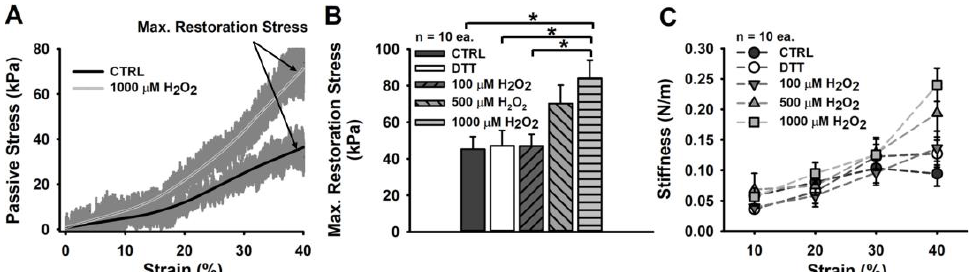
Figure 3. Passive restoration stress increases for larger H 2 O 2 concentrations. ( A ), average stress – strain curve for all CTRL fibres and all fibres exposed to 1000 µM H 2 O 2 . Maximum restoration stress is obtained at 40% strain. ( B ), while DTT and exposure to 100 µM H 2 O 2 had no marked effect on maximum restoration stress, high levels of H 2 O 2 (1000 µM) present with a significant increase over CTRL, DTT and 100 µM H 2 O 2 in fibres. Particularly, 1000 µM H 2 O 2 evoked twice the restoration stress in comparison to CTRL fibres. ( C ), axial stiffness ranged between 0.05 and 0.25 N/m, with CTRL fibres displaying the least increase from 0.05 N/m to 0.1 N/m, only. All other conditions revealed a marked gradual decrease in compliance and thus, a substantial increase in stiffness at higher strains (≥30%). Significance indicated as follows: * = p < 0.05.